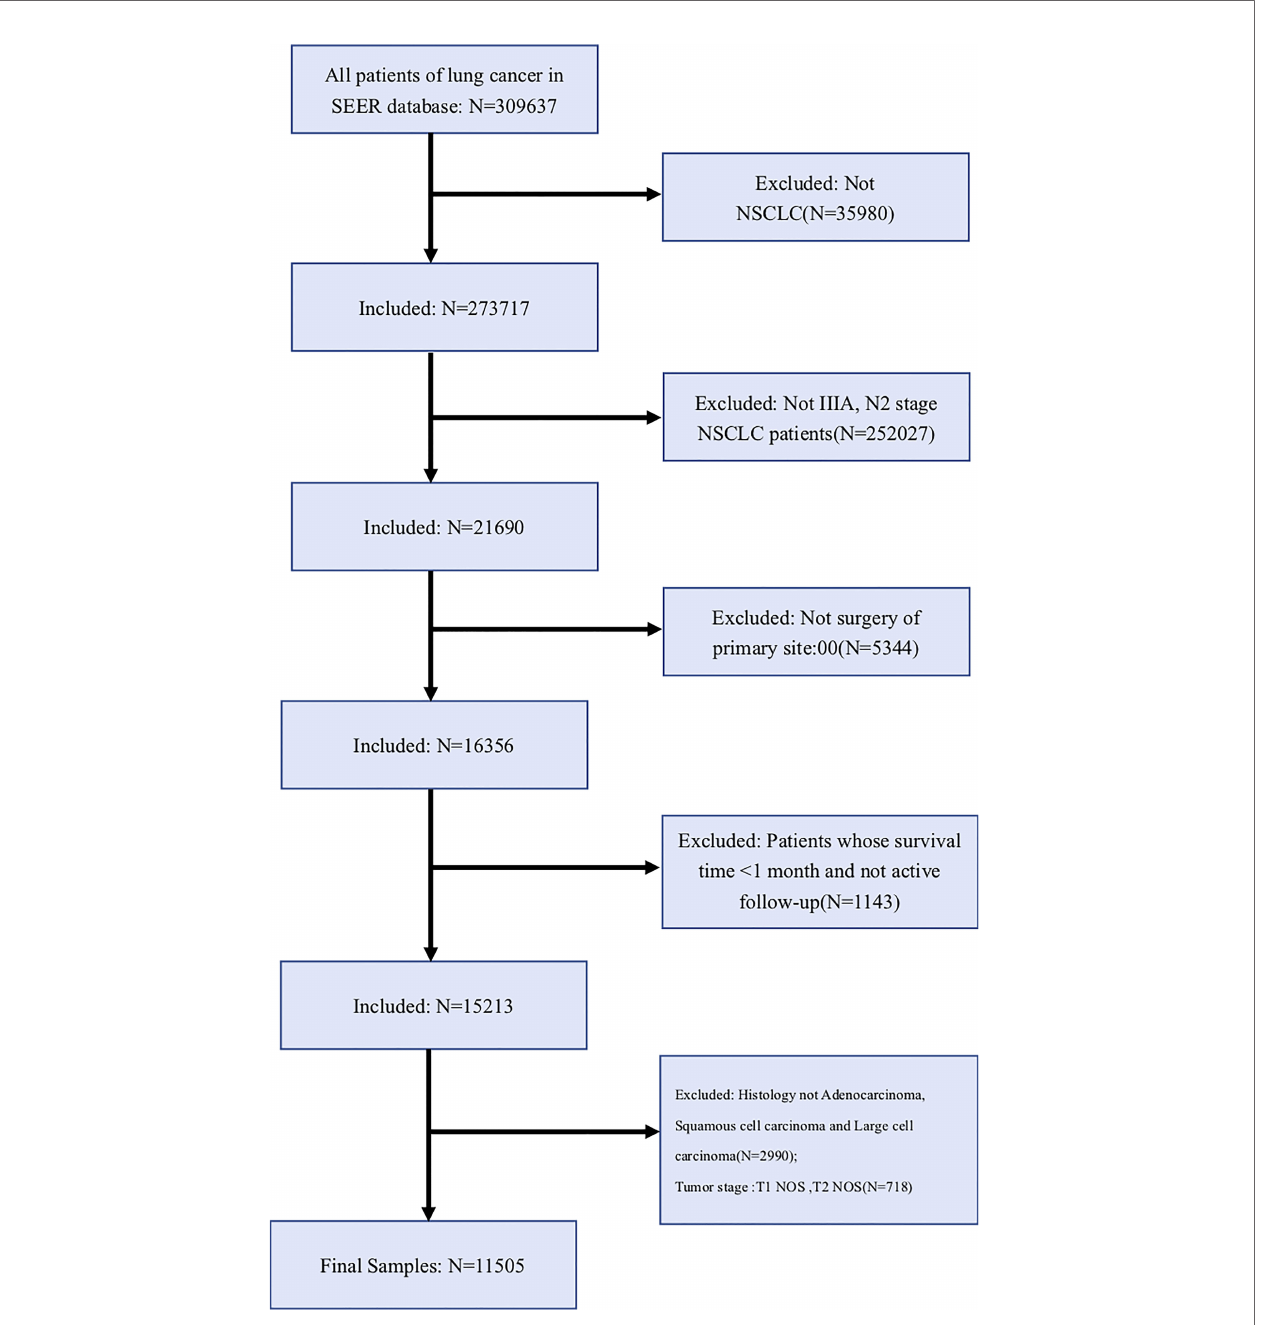
FIGURE 1 | The fl owchart for patient